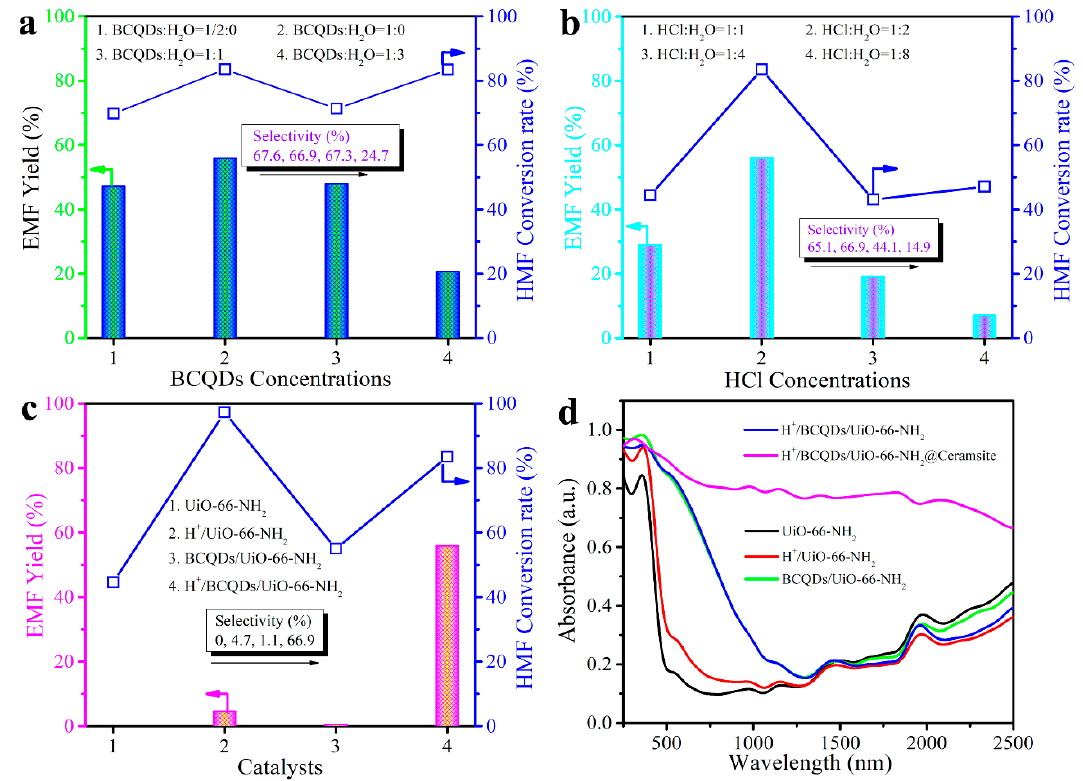
Figure 5. Acid catalytic performance of H + /BCQDs/UiO-66-NH 2 with ( a ) different BCQDs load amounts and ( b ) different hydrochloride acid used for the catalytic acidification; ( c ) catalytic activity and ( d ) light absorption properties of UiO-66-NH 2 , H + /UiO-66-NH 2 , BCQDs/UiO-66-NH 2 , and H + /BCQDs/UiO-66-NH 2 .